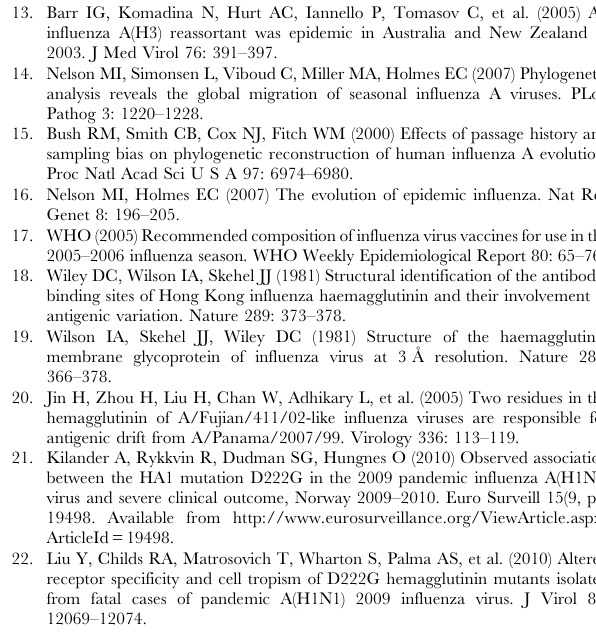
Figure S1 Bootscan analysis for reassortant UK viruses.